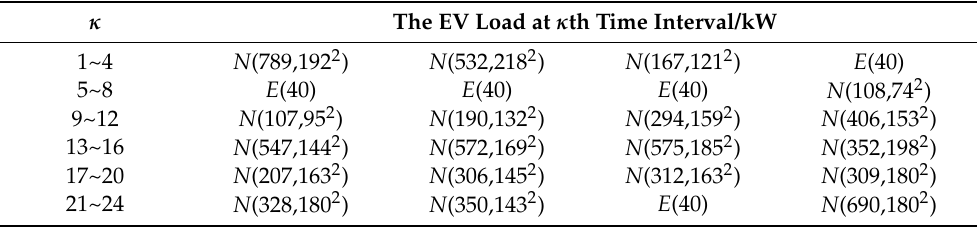
Table 3. The probability distribution of EV load change at the FCS B in different time intervals in a day. κ The EV Load at κ th Time Interval/kW